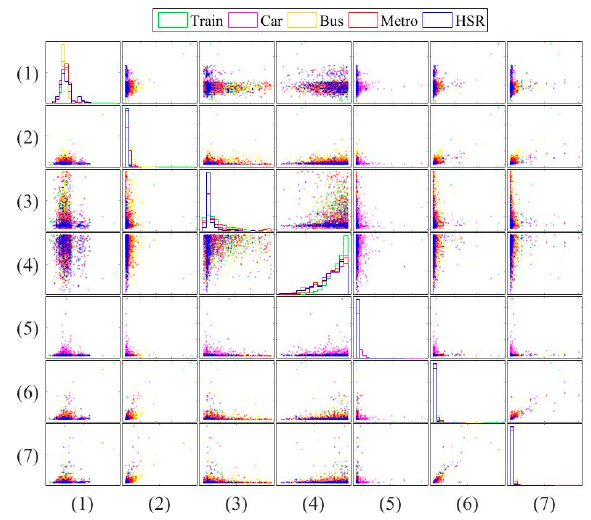
Figure 6. Pairwise comparison of the traditional features in vehicular mode.